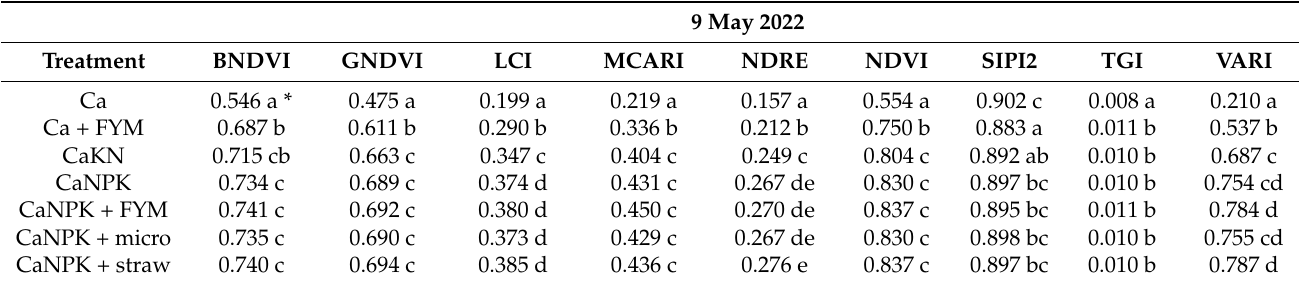
Table 5. Means of vegetation indices in field experiment 2 (monoculture of rye) and comparisons of means based on Tukey’s